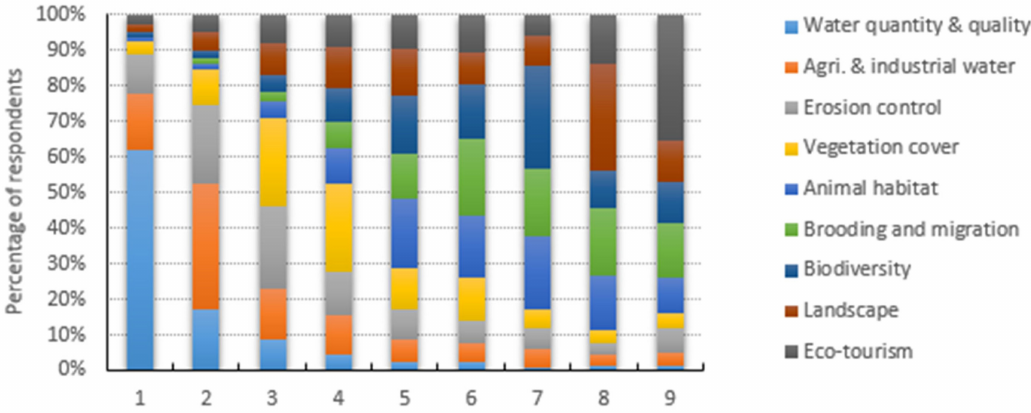
Figure 3. Rank score of Wei river respondents for ecological attributes from most important “1” to least